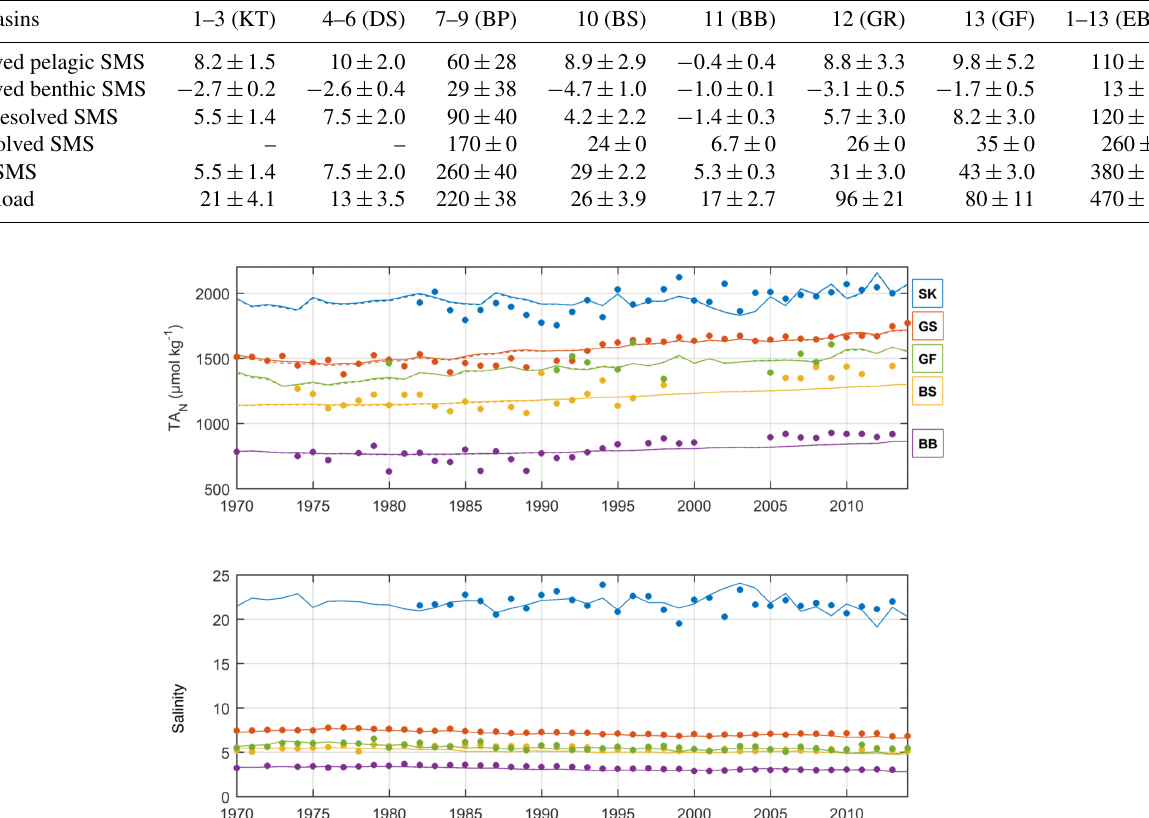
Figure 5. Annual mean observed (dots) and modeled (lines) normalized surface water TA (TA N , µmolkg − 1 ) and salinity in five sub-basins. Full and dashed lines represent the scenarios in which the unresolved TA sources are added as land loads or sediment release, respectively. Model data from sub-basins 3 (SK), 9 (GS), 10 (BS), 11 (BB), and 13 (GF) are compared to observed data at the Anholt East, BY15, US5B, F9/A13, and LL7 stations,